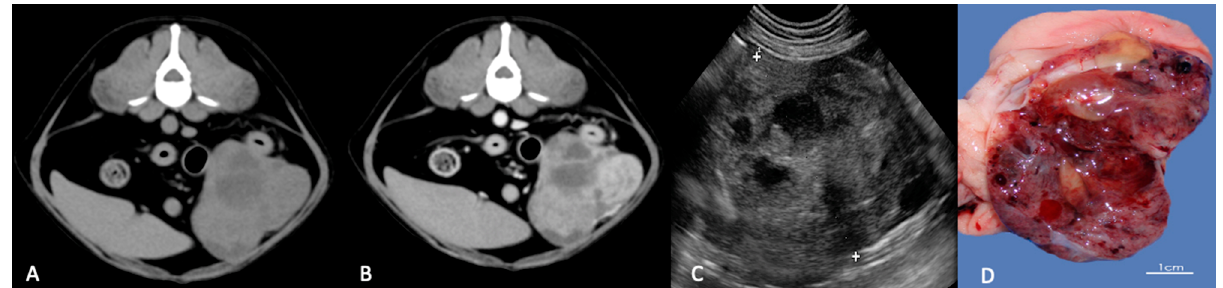
Figure 1. The computed tomography (CT) appearance of a granulosa cell tumour that appears as a large, well-defined low-attenuation ovarian mass. ( A ) Non-enhanced CT scan shows multi cystic soft-tissue mass. ( B ) After contrast administration, CT scan shows mass as mildly and non-homogeneously enhanced. ( C ) Ultrasound longitudinal right ovarian mass with heterogeneous echotexture and multiloculated solid and cystic mass. ( D ) Sagittal cut of the right ovary containing polycystic structures.